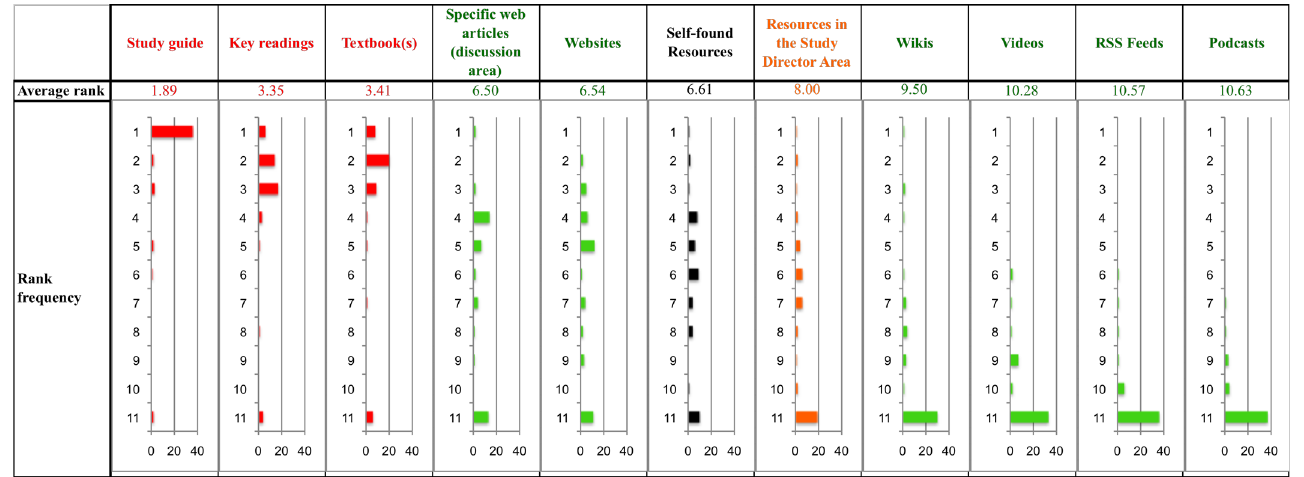
Resource Use, Average Rank, and Rank